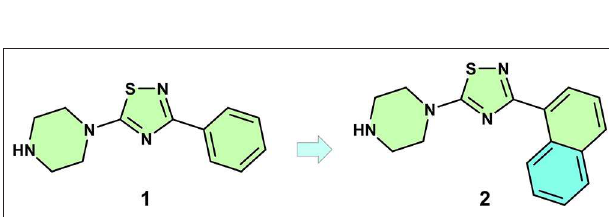
FIGURE 3 | Fragment optimization approaches: fragment growing (A) , fragment linking (B) , and fragment merging (C) . The surface of the binding site is depicted in gray. The red and gray colors represent the level of complementarity of ligand with the active site. Pockets with low complementarity with ligand are colored in red; pockets with high complementarity with ligand are highlighted in